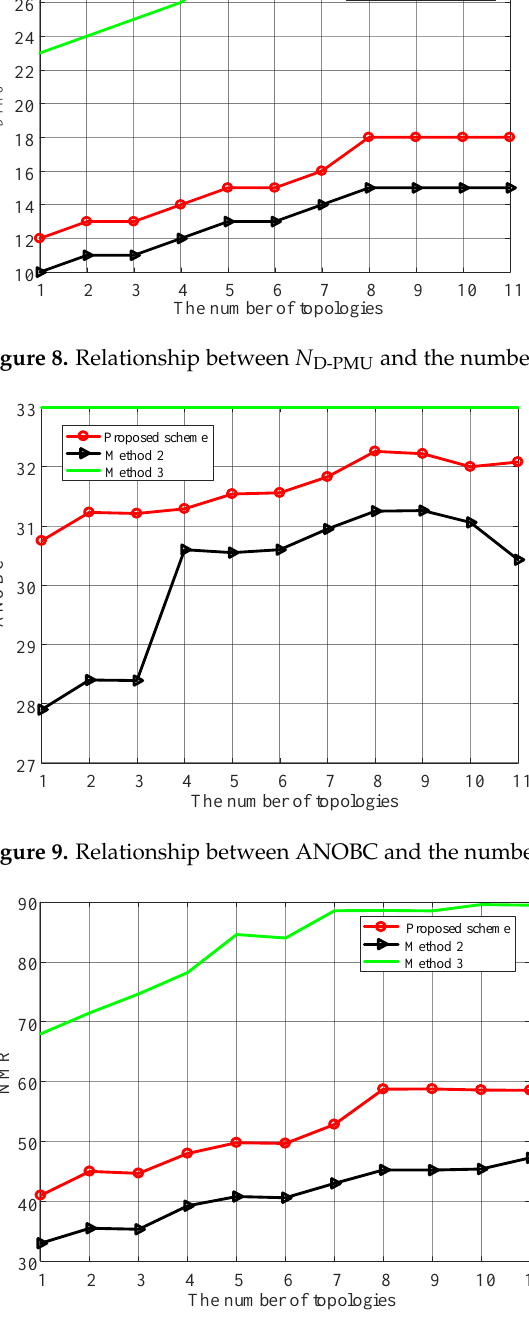
Figure 10. Relationship between NMR and the number of topologies.